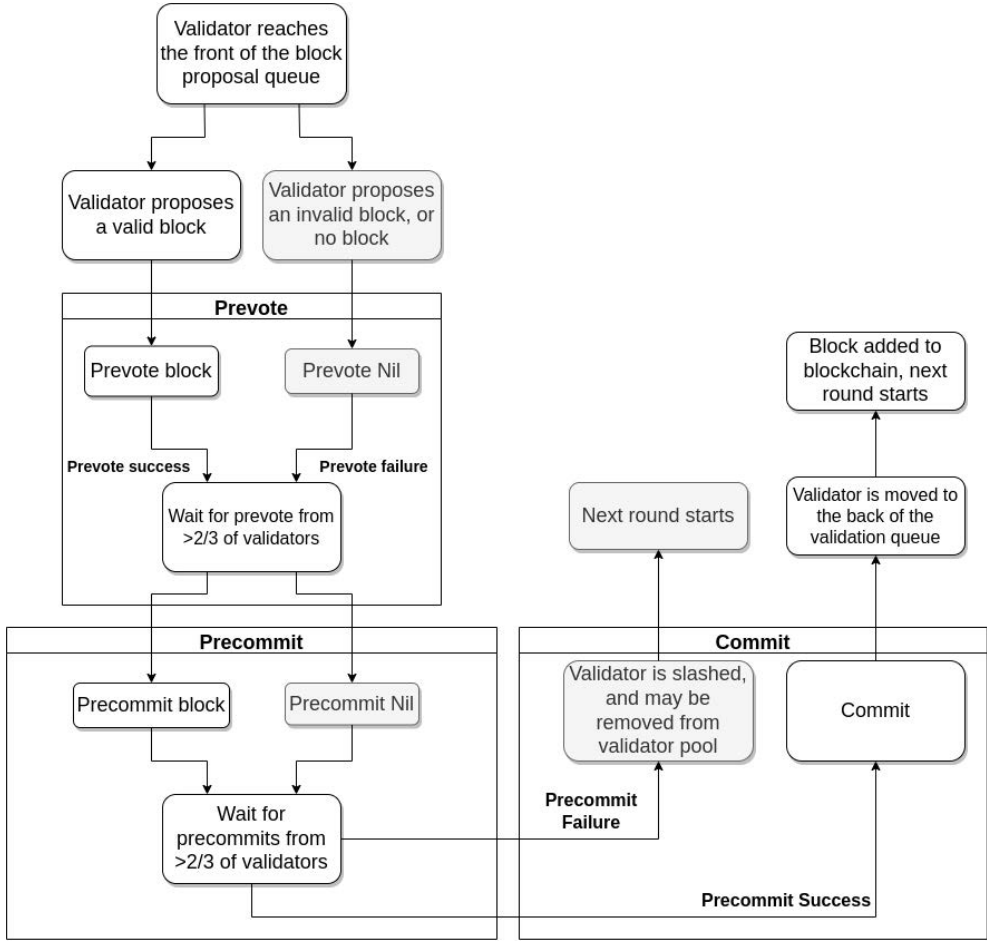
Figure 10. Tendermint